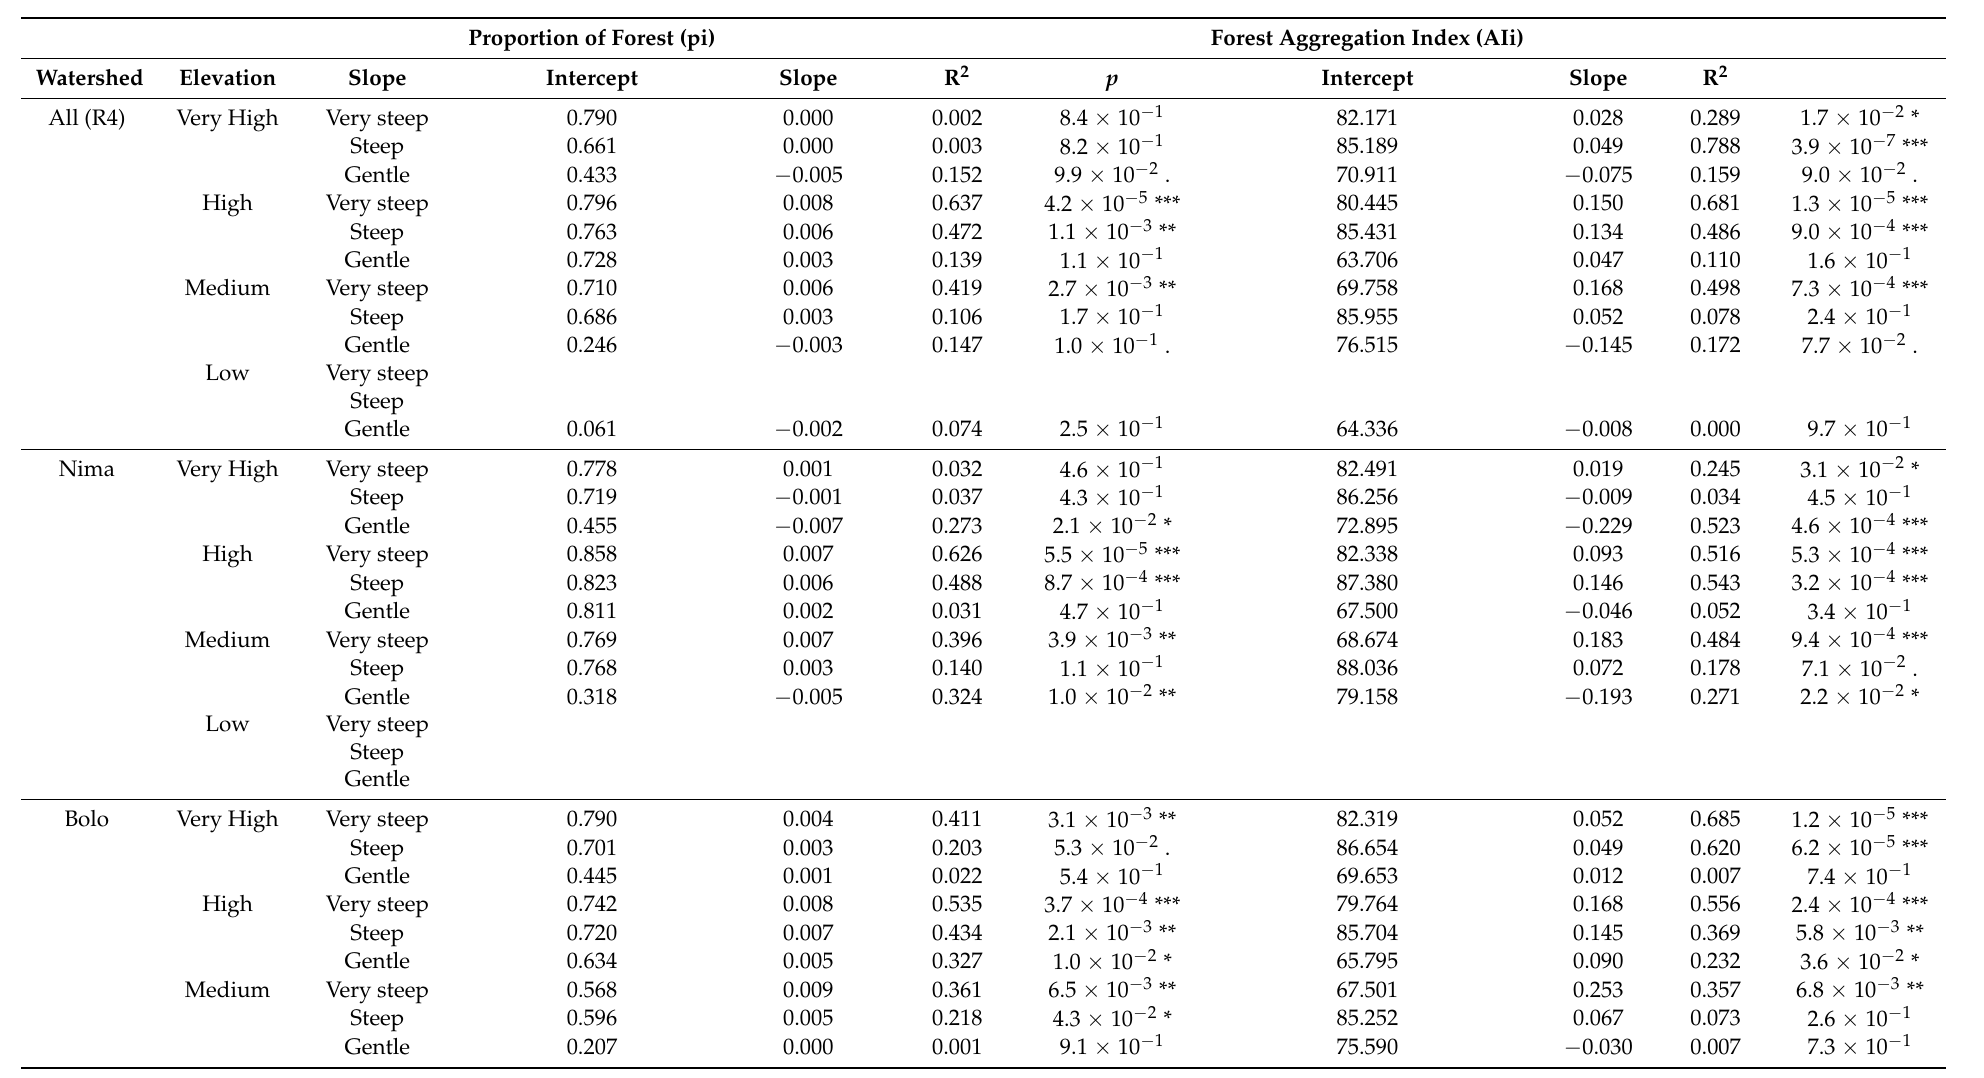
Table 2. Results of linear models between two forest metrics and time as a function of the combined effects of Elevation and Slope. . <0.1, * <0.05, ** <0.01, *** <0.001. Proportion of Forest (pi) Forest Aggregation Index